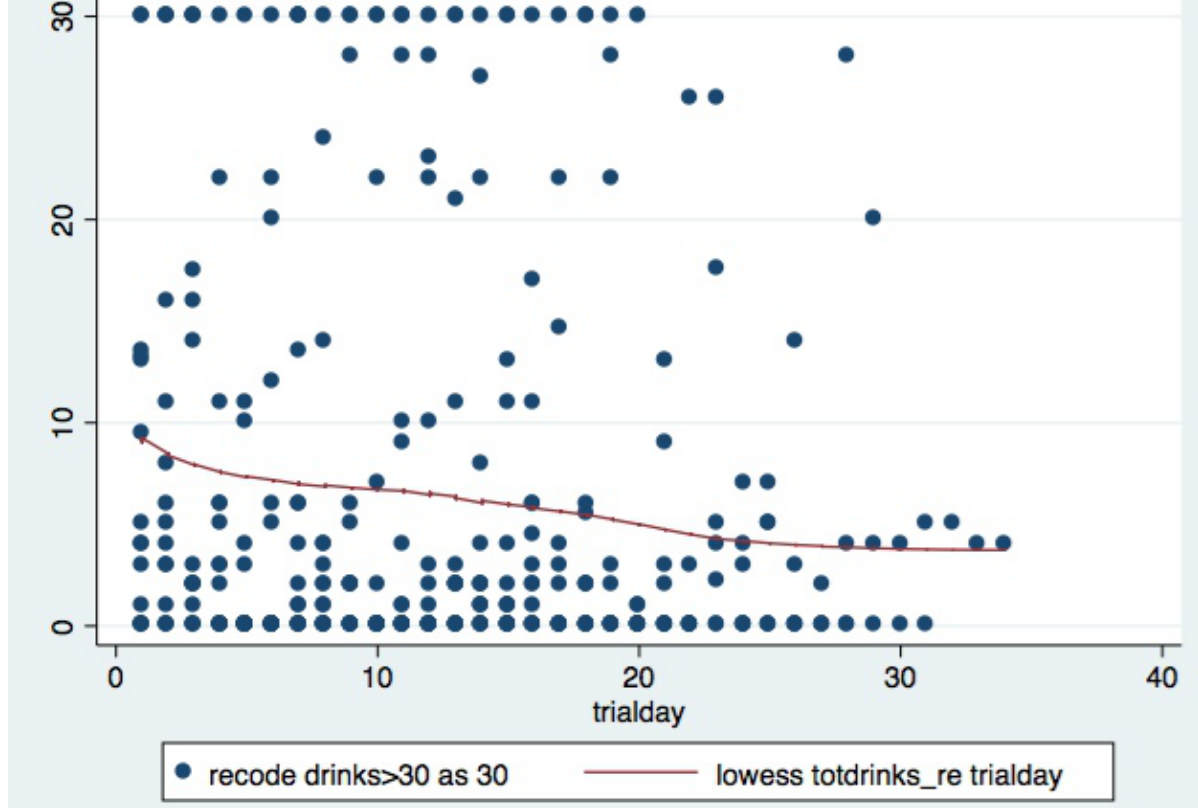
Number of questions completed in each survey,